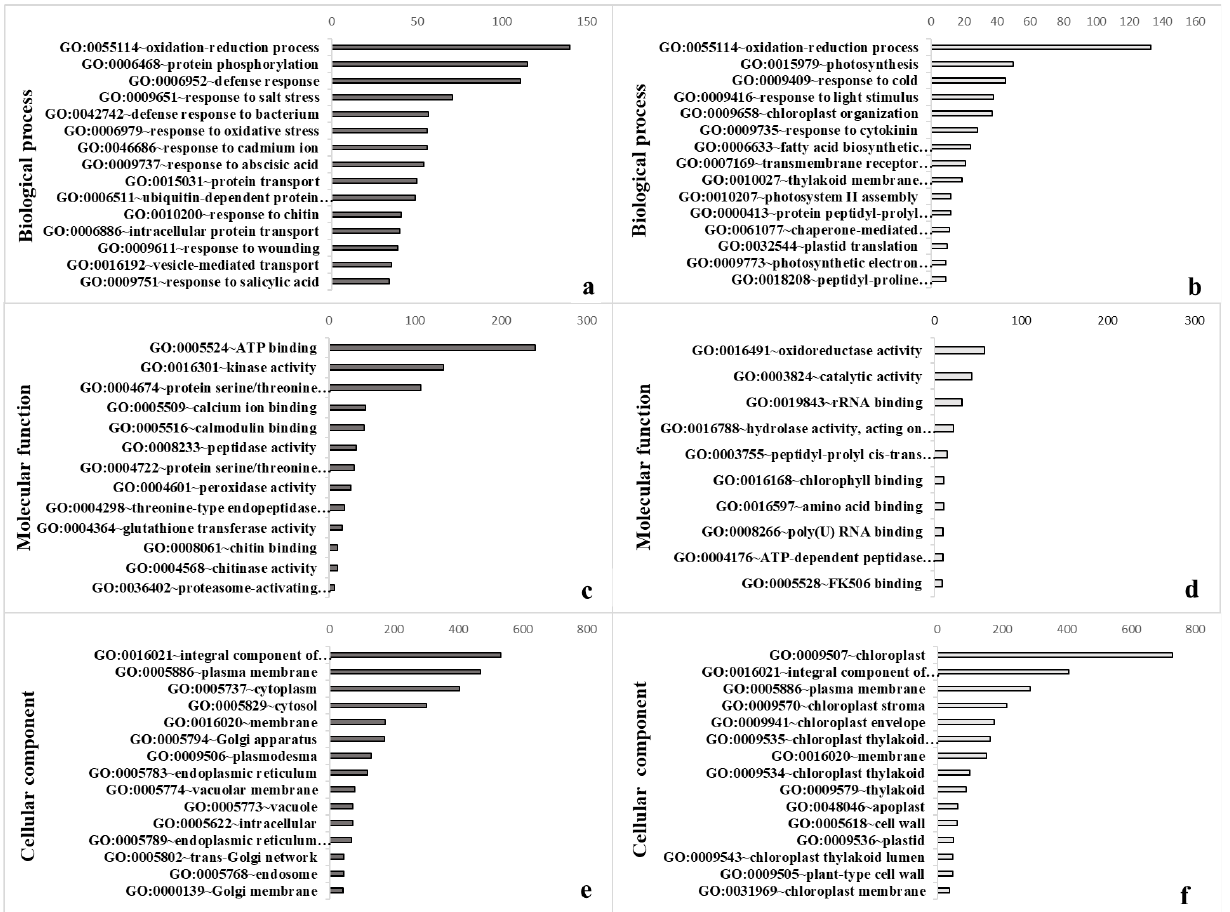
Figure 2. Gene ontology enrichment analysis of the DEGs. The enriched genes were sorted into three categories according to gene function: ( a , b ) biological process (e.g., active in defense responses and photosynthesis), ( c , d ) genes involved in molecular functions (redox and energy metabolism), and ( e , f ) genes responsible for synthesis and organization of cellular components (e.g., with importance for membrane and organelle structures). Up-regulated genes are listed on the left panel (dark grey) and down-regulated genes on the right (light grey).